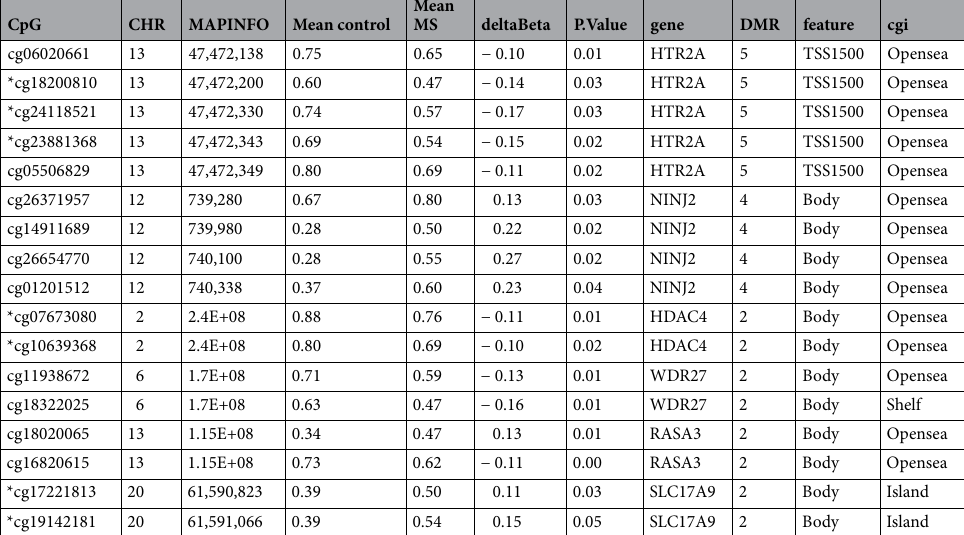
Table 3. DMRs in validation cohort.